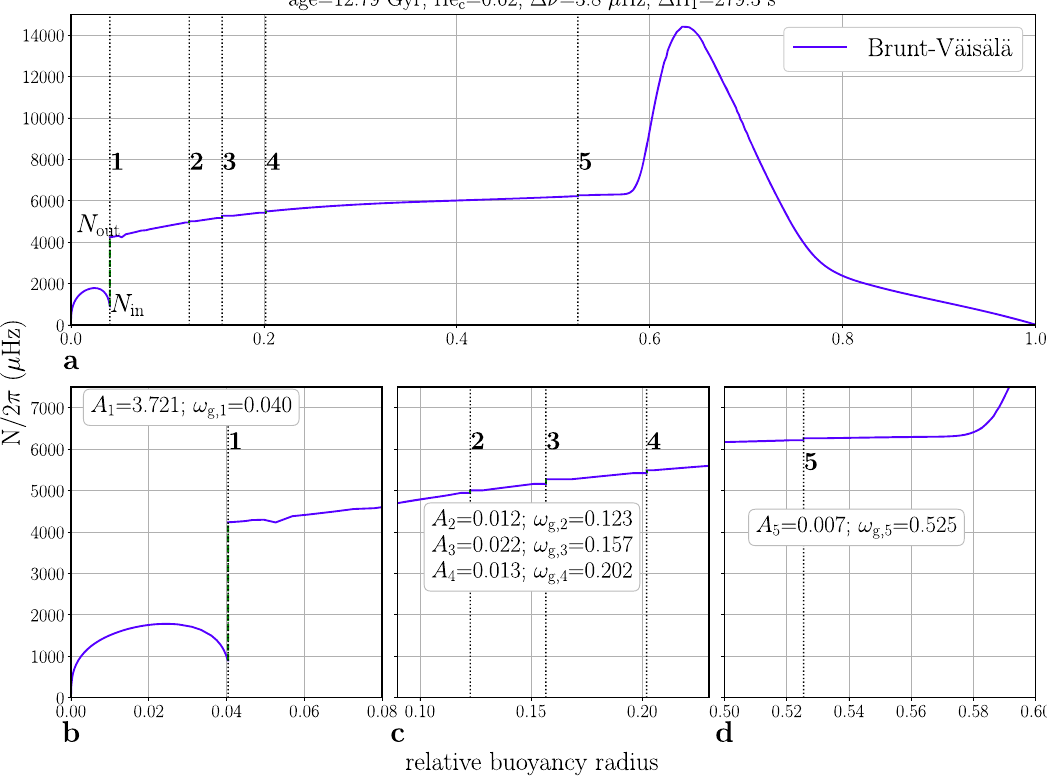
Fig. 2 | Brunt-Vaisälä frequency as a function of the relative buoyancy radius ( x = e ω r g = ω g )foroneofthecomputedmodels(inviolet). Theoriginoftheabscissa marks the inner edge of the g-mode cavity. a shows the complete radiative cavity and b , c , d highlight speci fi c parts. The black dotted line labeled 1 (in a , b ) corre- spondstotheglitchposition( x * = e ω * g = ω g )duetothechemicaldiscontinuitycaused